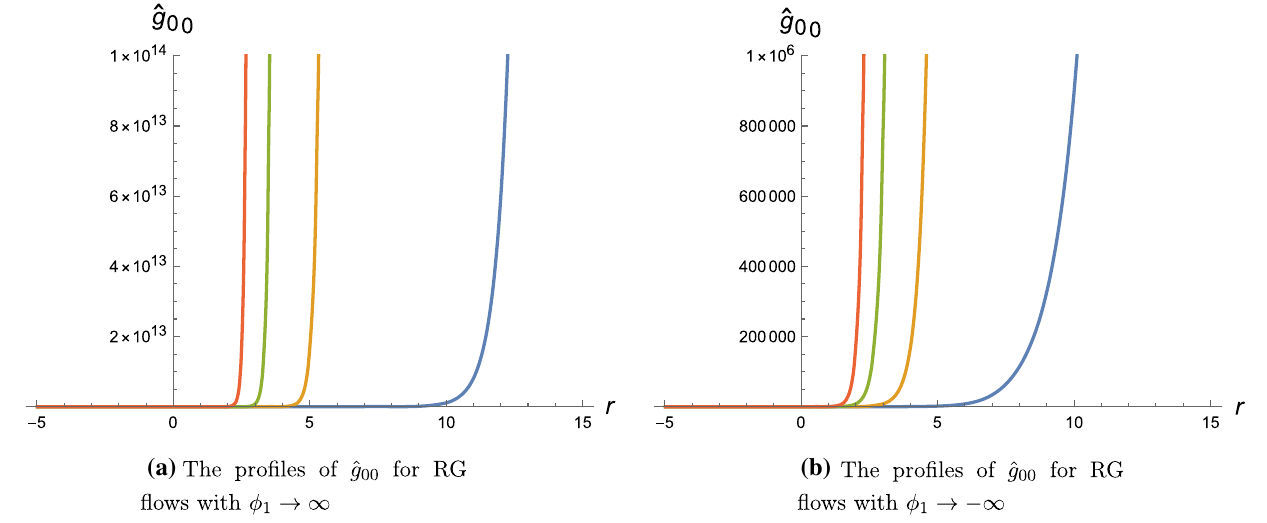
Fig. 9 Behaviors of the ( 00 ) -component of the eleven-dimensional metric for the RG flows given in Figs. 7 and